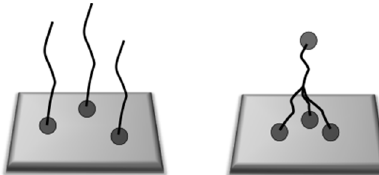
Figure 2. Linear polymer chains with one grafting point ( left ) compared to a four-arm star-shaped polymer with multiple grafting points ( right ).